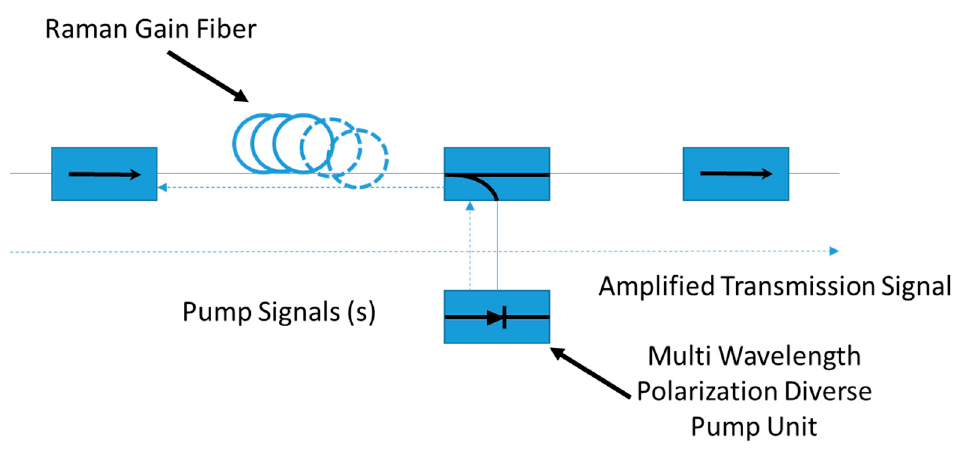
Figure 5. Discrete fiber Raman amplifier (FRA) scheme with pump power confined to the lumped